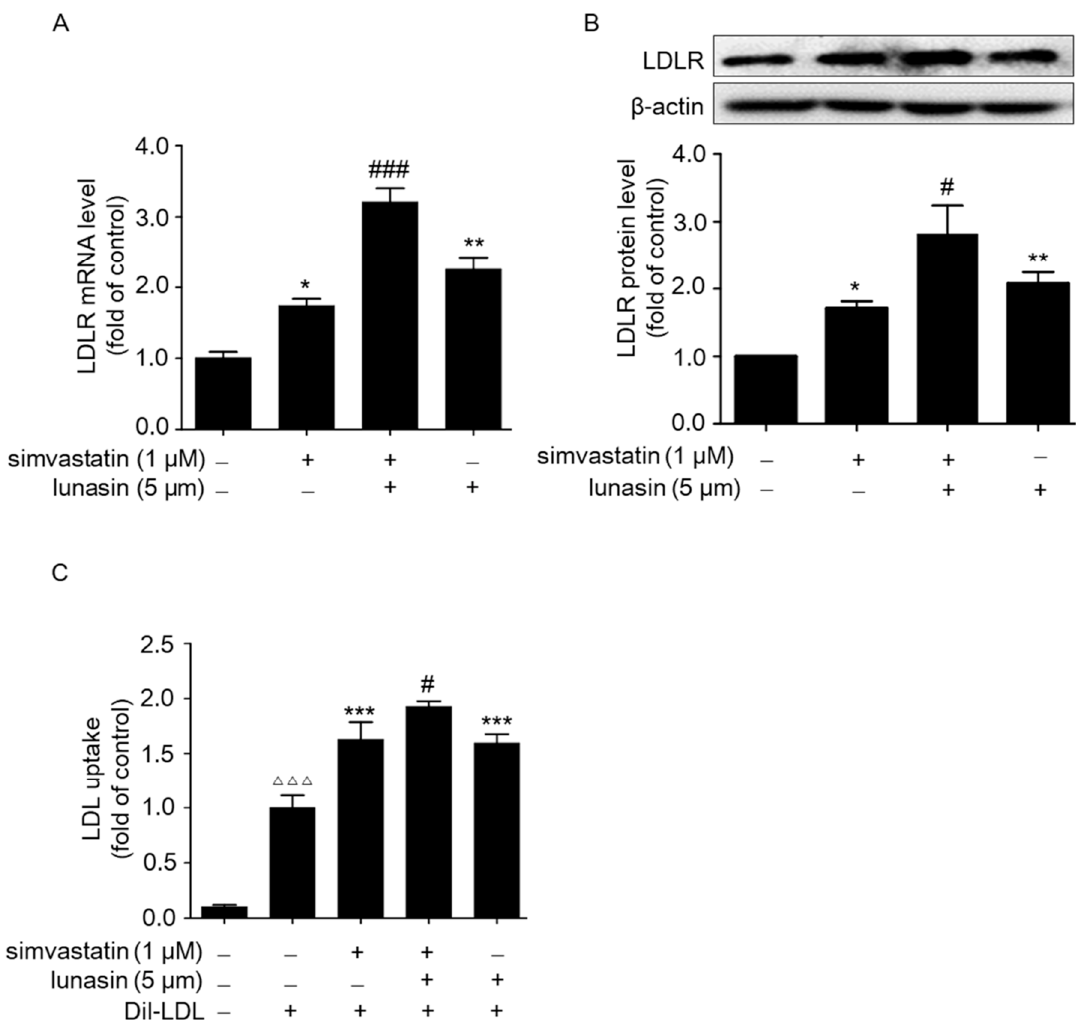
Figure 2. Effects of simvastatin in combination with lunasin treatment on the LDLR and LDL uptake levels in HepG2 cells. HepG2 cells were treated with simvastatin and/or lunasin for 24 h. The mRNA ( A ) and protein ( B ) levels of LDLR were analyzed by qRT-PCR and Western blot using β -actin as an internal control, respectively. * p < 0.05, ** p < 0.01 vs. the control group; # p < 0.05, ### p < 0.001 vs. the simvastatin group. ( C ) LDL uptake was assessed in HepG2 cells after treatment with simvastatin and/or lunasin for 24 h on a fluorescence plate reader. ΔΔΔ p < 0.001 vs. the negativecontrol group; # p < 0.05 vs. the simvastatin group; *** p < 0.001 vs. the 20 μ g/mL Dil-LDL group ( n = 3, means ± SEM). Dil-DLD: LDL labeled with 1,1 ′ -dioctadecyl-3,3,3 ′ ,3 ′ -tetramethylindocarbocyanine perchlorate. 2.3. Lunasin Reduces LDLR Degradation by Counteracting Simvastatin-Induced Up-Regulation of PCSK9 in ApoE − / − Mice